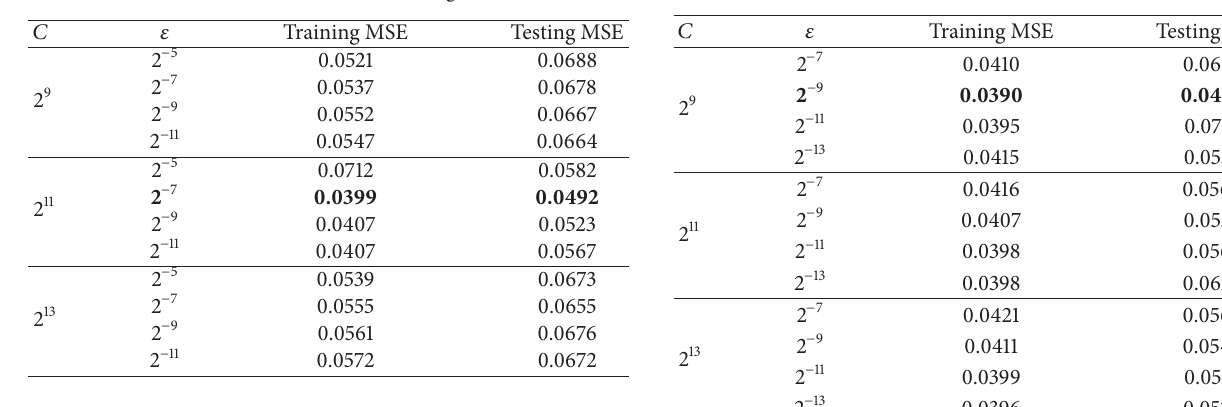
Table 1: Model selection results of the single SVR model.